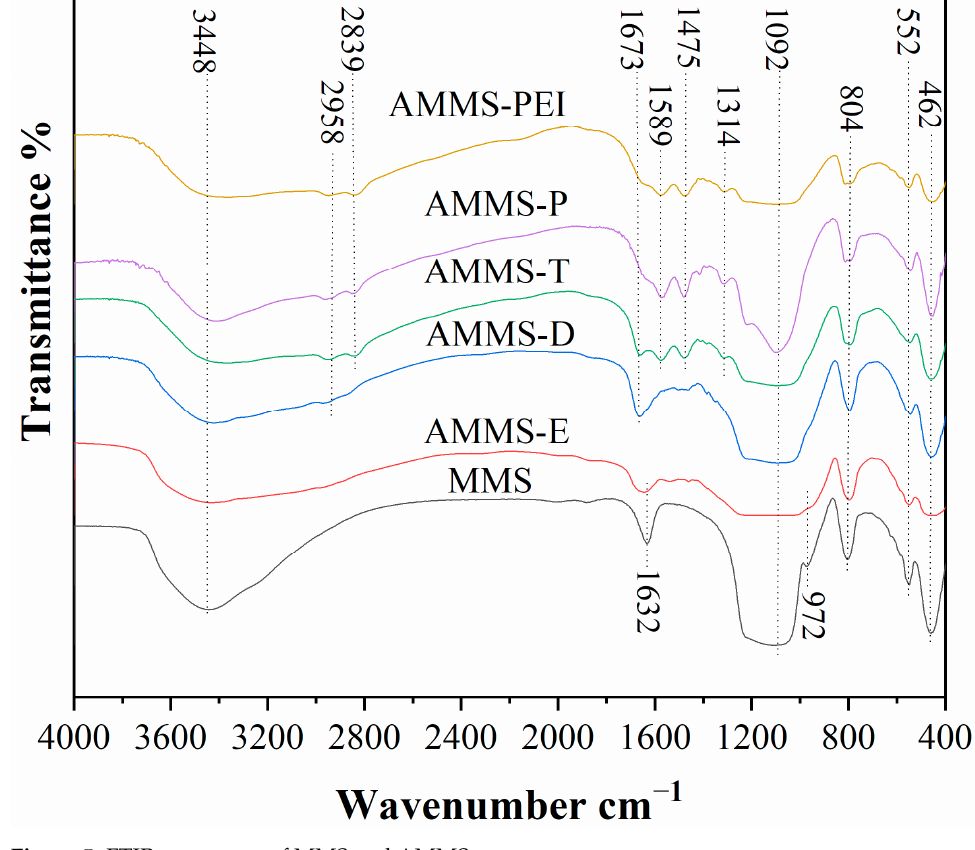
Figure 5. FTIR spectrums of MMS and AMMS.